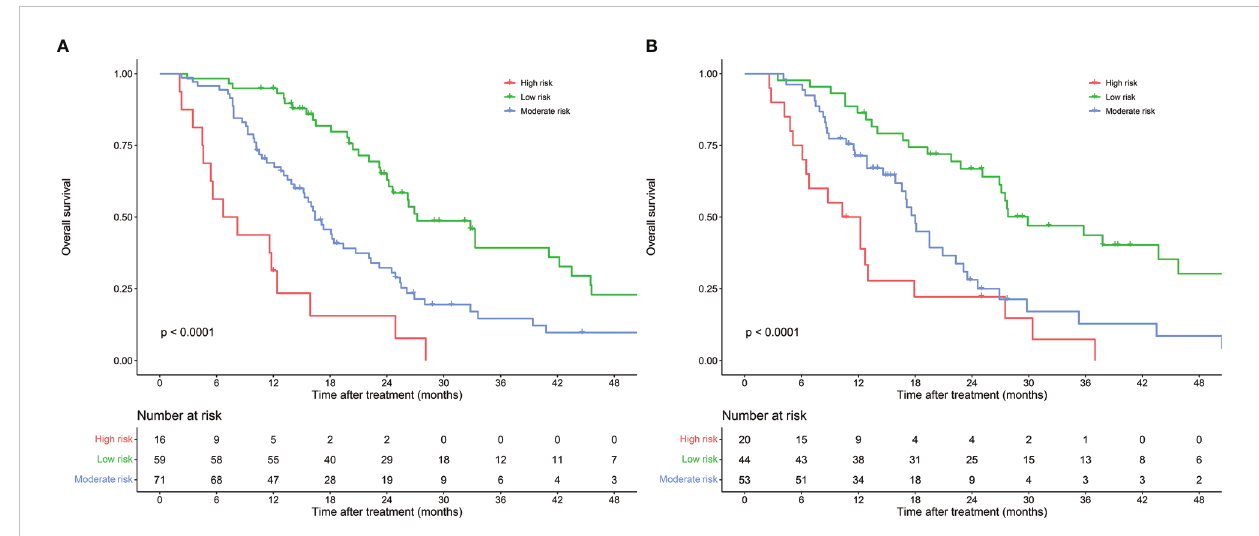
FIGURE 8 Risk strati fi cation of nomogram model for patients with resectable pancreatic cancer in the training cohort (A) and validation cohort (B)